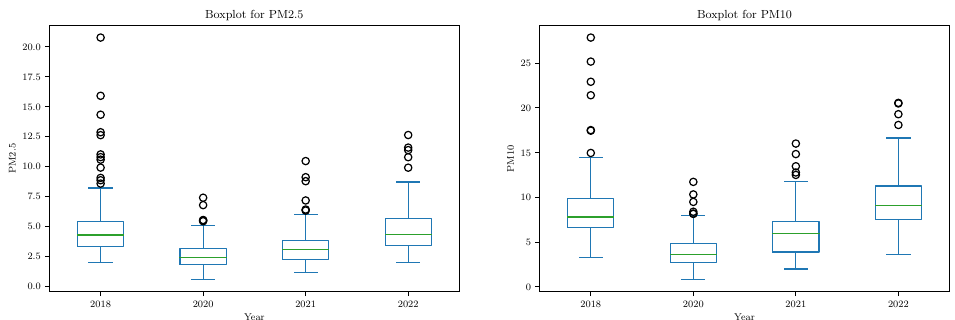
Figure 4. Boxplot for PM2.5 ( left ), and PM10 ( right ) for the data in the observed period. As the PM concentrations are not normally distributed, the non-parametric Mann- Whitney and Kruskal-Willis tests are performed on the observed data. Both tests